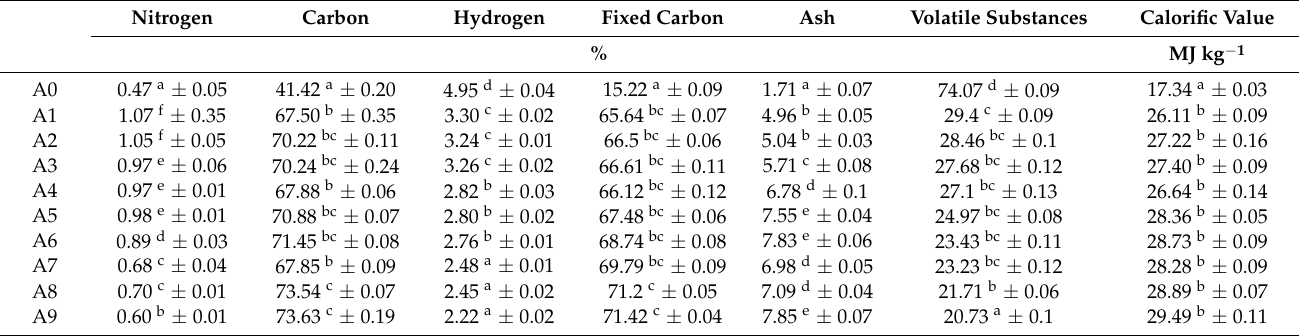
Table 3. Contents of total nitrogen, total carbon, hydrogen, fixed carbon, ash, volatile substances, and calorific value in non-processed biomass of apple branches and in the